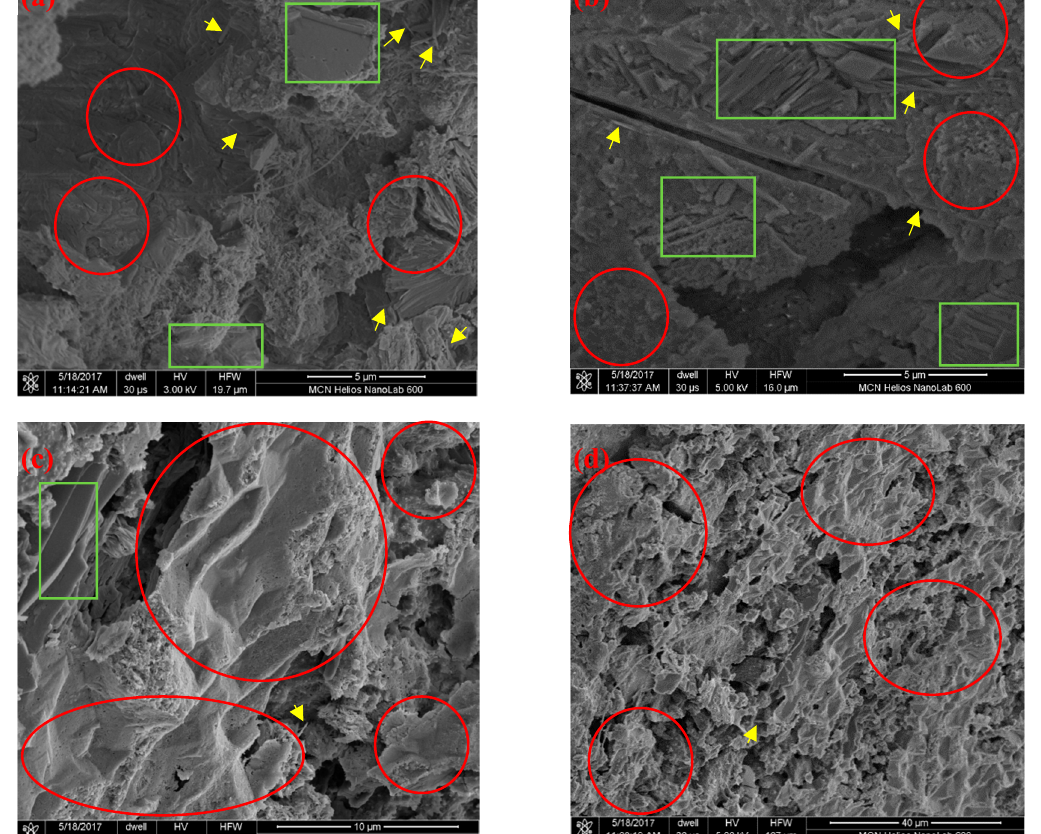
Figure 8. SEM images: ( a ) GONM without GO; ( b ) GORM without GO; ( c ) GONM with w GO = 0.05 wt‰; ( d ) GORM with w GO = 0.05 wt‰ (green rectangle: CH crystal; yellow arrow: AFt; red circles: C-S-H gel).